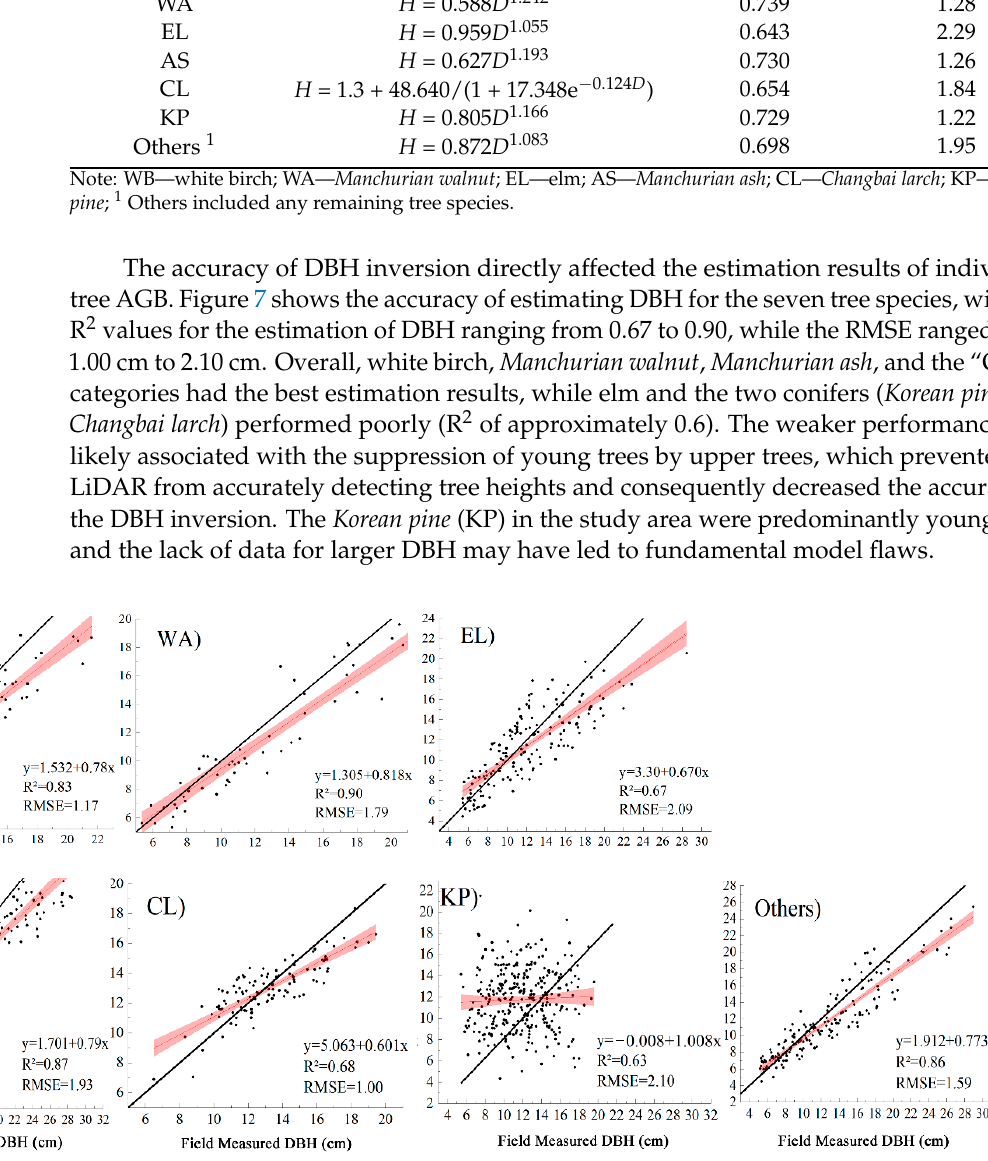
Figure 7. Accuracy assessment between measured DBH and estimated DBH using ALS data. Shaded areas represent 95% confidence intervals, and solid lines are the 1:1